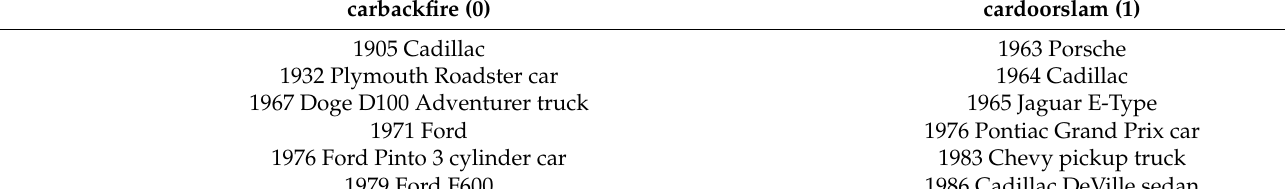
Table 1. Order of the various classes with a partial list of audio